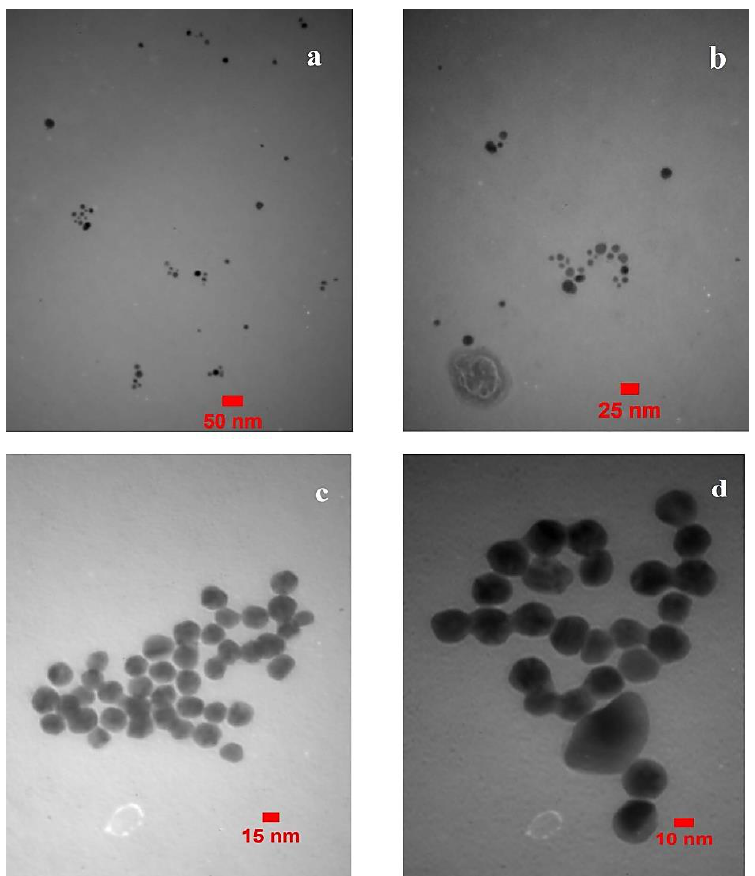
Figure 7. TEM image of the used plasmonic NPs: ( a ) Au NPs; ( b ) Ag NPs; ( c ) Au – Ag NPs; and ( d ) Ag – Au NPs. Reprinted with permission from [75] . Copyright © 2020, Elsevier. In the experiment performed by Amoli-Diva et al., a xenon lamp was chosen as the optimal light source. The half-life, kinetic properties, and rate constant were evaluated for each synthesized photocatalyst. Reactions involving the photodegradation of ofloxacin (OFX), methylene blue (MB), and dyes present in industrial wastewater were studied